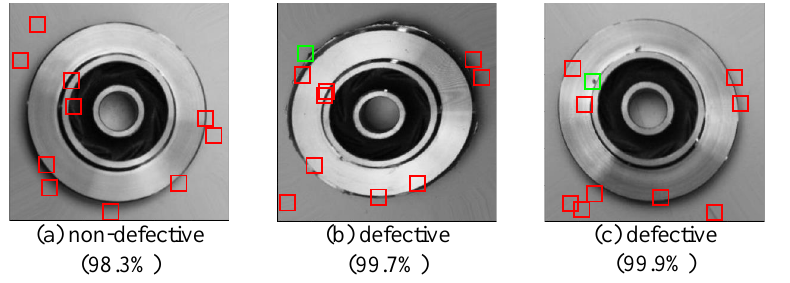
Figure 14. The prediction results of a defective casting and two non-defective castings. ( a ) A non- defective case, whose probability of being non-defective is 98.3%; ( b ) A defective casting case (with fins), whose probability of being defective is 99.7%; ( c ) A defective casting case (with open holes), whose probability of being defective is 99.9%. The observation windows of the normal agents are marked in red, and the observation windows of the defects detected agents are marked in green. Table 1. Performance comparison with different